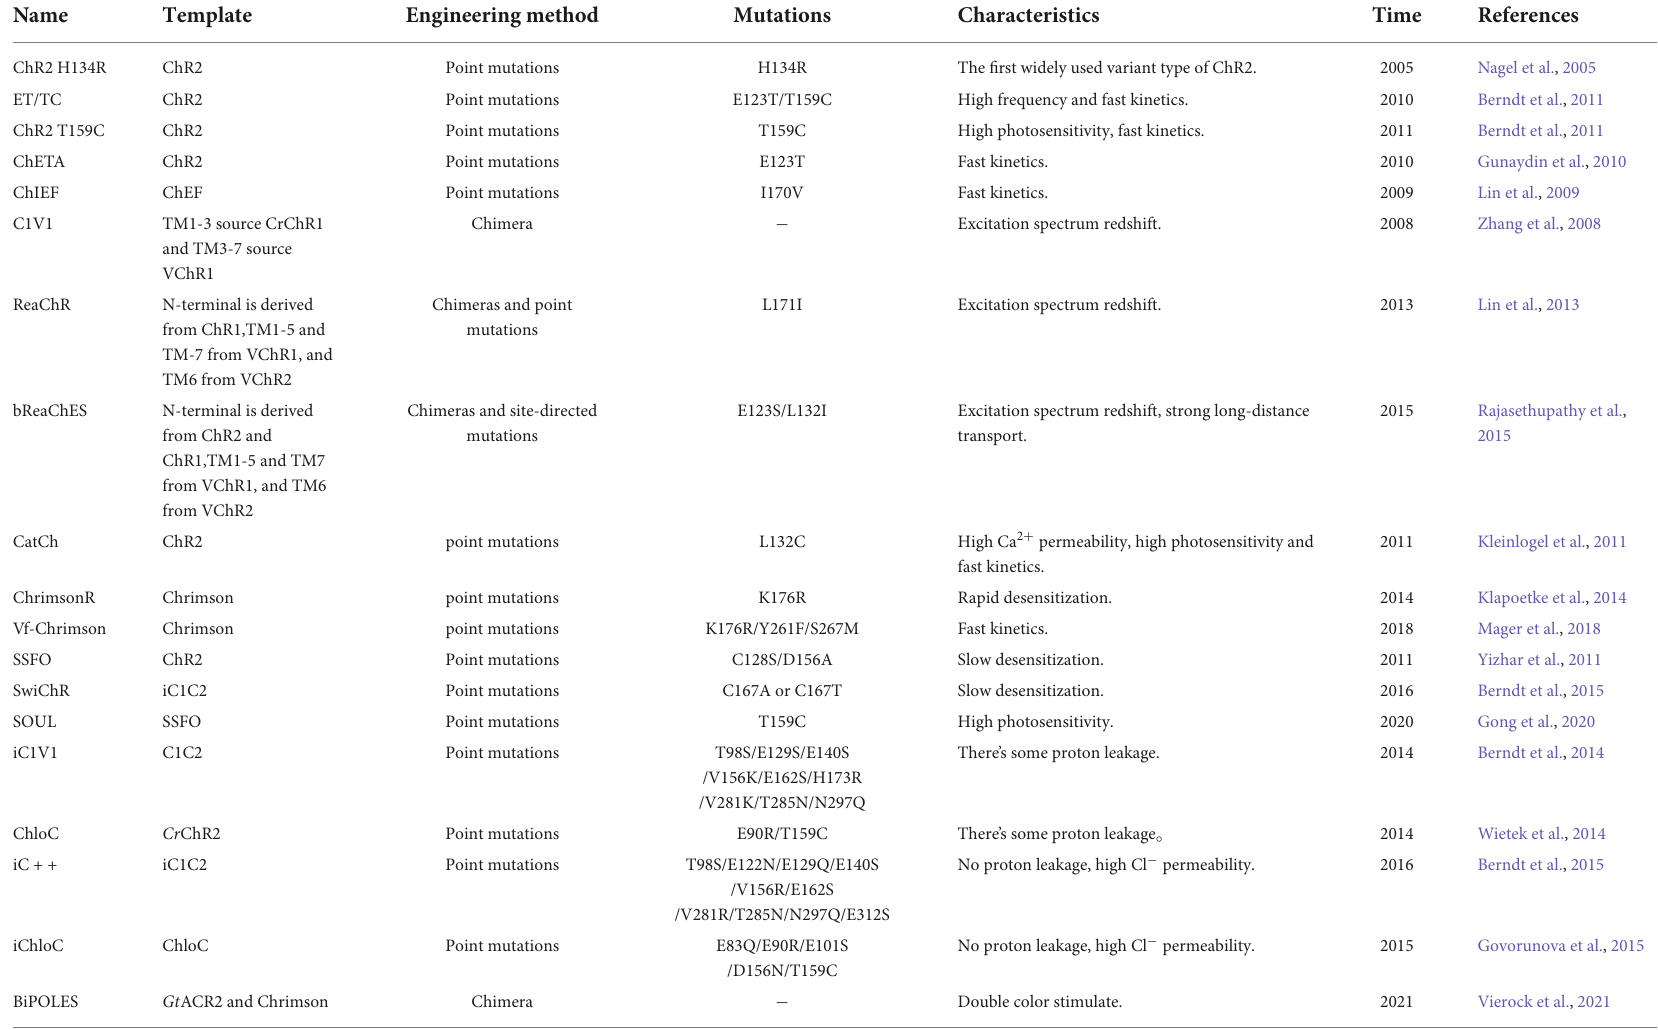
TABLE 2 Widely used engineered